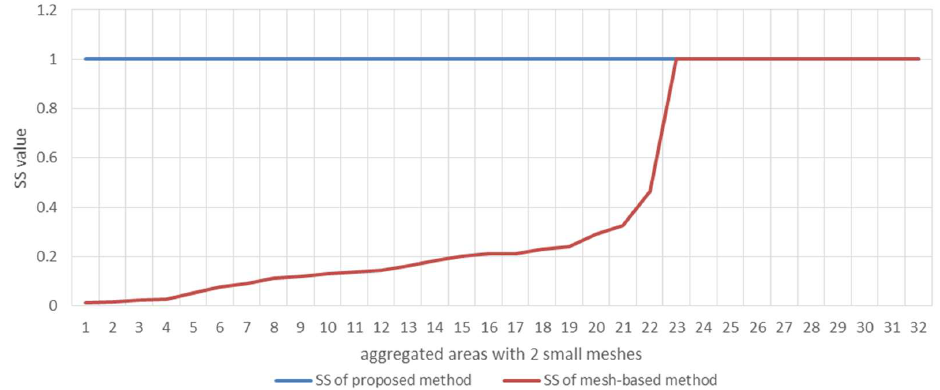
Figure 11. Comparison of the SS values for each method based on 32 aggregated areas with 2 small meshes.